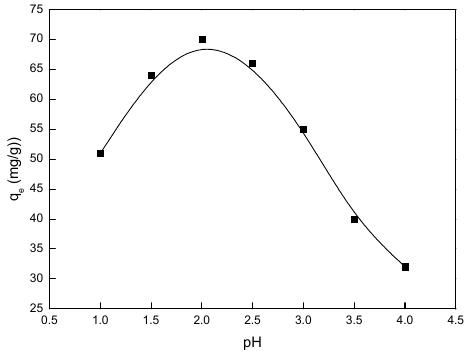
Figure 5. The influence of pH on the adsorption of Pd(II).